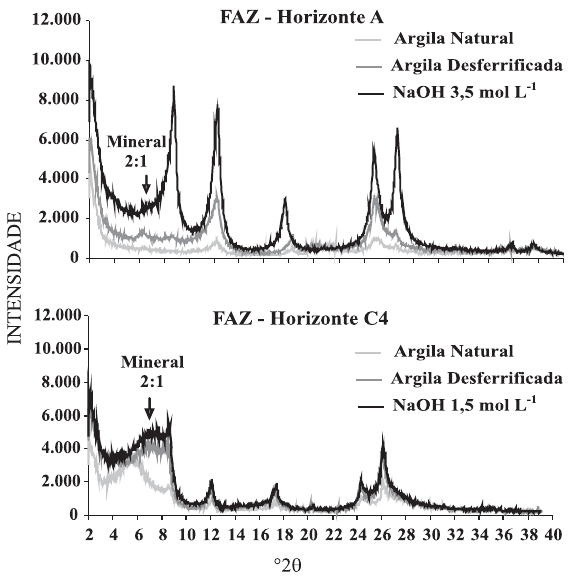
Figura 4. Difratogramas de raios X de amostras orientadas de argila natural e desferrificada, antes e após os tratamentos com soluções de NaOH, nas concentrações de 3,5 e 1,5 mol L -1 , nos horizontes A e C4, respectivamente, no perfil da Fazenda Experimental do Canguiri (FAZ) da UFPR. No horizonte A, o espaçamento basal d(001) ficou em torno de 1,41 nm; no horizonte C4, variou de 1,55 nm (natural) a 1,18 nm (NaOH).